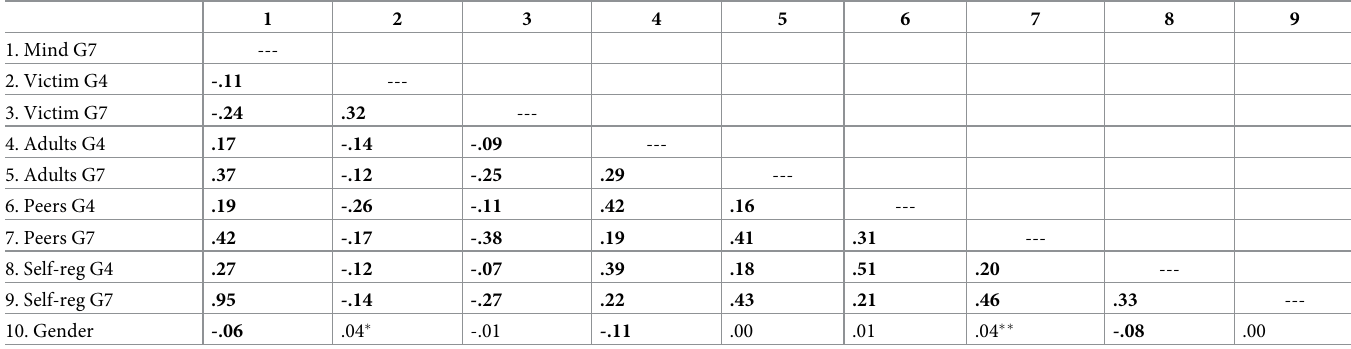
fit for the measurement and structural models for both the cross-sectional and longitudinal analyses were good: CFI = .972 - .991, TLI = .964 - .988, RMSEA = .017 - .036, SRMR = .017 -